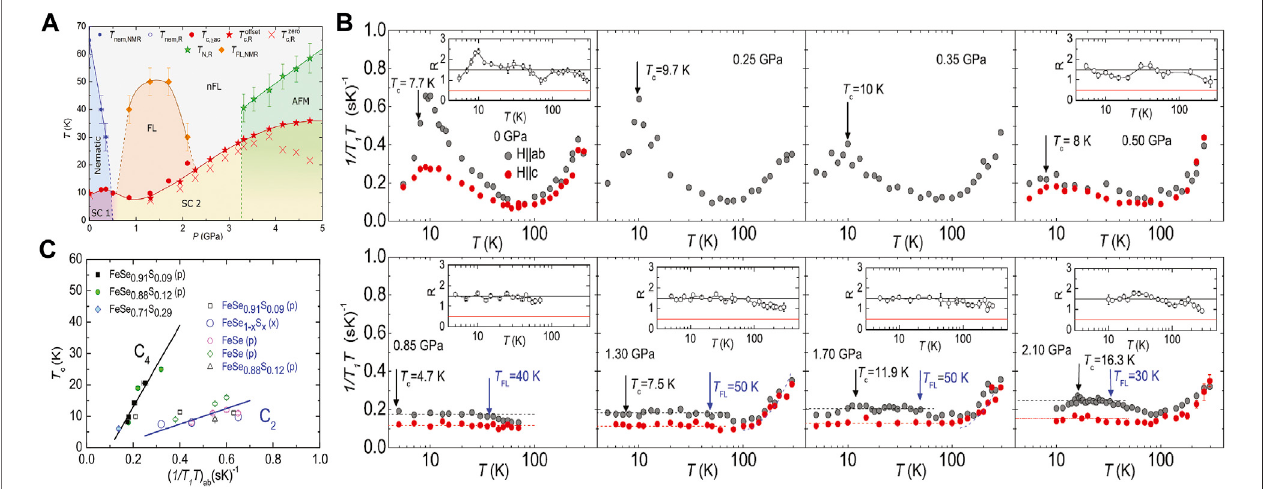
FIGURE2|(A) ElectronicphasediagramofFeSe 0.91 S 0.09 underpressure.ReprintedwithpermissionfromK.Ranaetal.,PhysicalReviewB101,180503(R),2020 [37]. Copyright (2020) by the American Physical Society. (B) Temperature- ( T -) dependence of 1/ T 1 T in single crystalline FeSe 0.91 S 0.09 measured at the